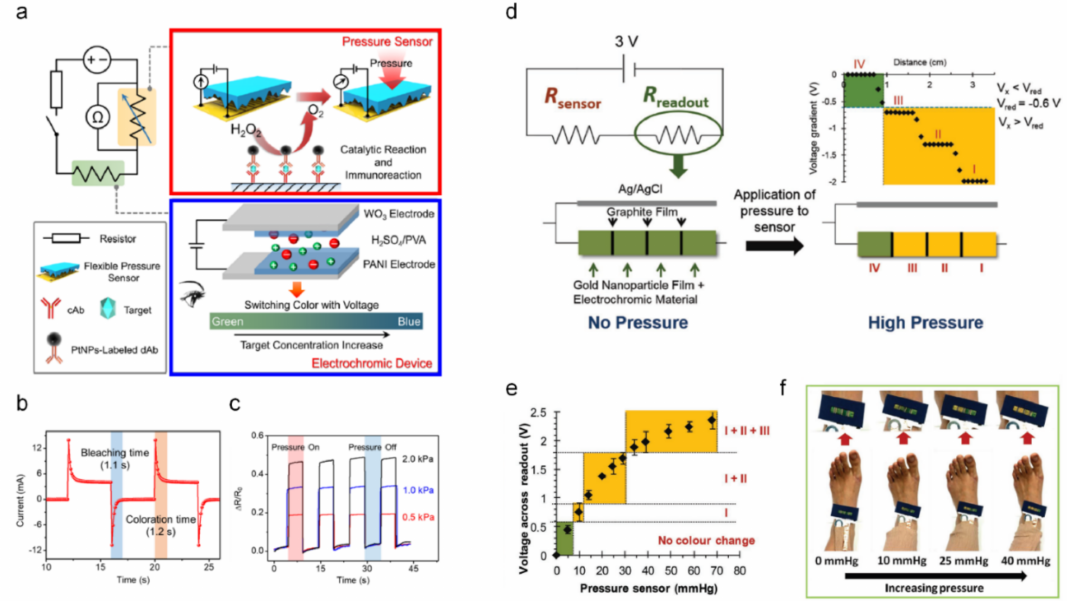
Figure 2. Pressure sensor integrated with EC visual detection (( a – c ) adapted with permission from ref. [24], copyright 2021 American Chemical Society and ( d – f ) adapted with permission from ref. [25] copyright 2016 Wiley-VCH Verlag GmbH & Co.). ( a ) Schematic circuit diagram of the pressure-based immunoassay platform; flexible pressure sensor by catalytic reaction and immunoreaction (red box) and voltage-regulated ECD as a visualized readout (blue box). ( b ) Color switching time of the ECD. ( c ) Pressure response of the designed skin-inspired pressure sensor. ( d ) Operating mechanism of the paper-based ECD is incorporated with a pressure sensor (Rsensor). The paper-based readout system consists of resistive graphite separators and gold nanoparticle segments (readout) with Prussian blue/polyaniline as electrochromic materials. ( e ) Visual readout of pressure vs. voltage by a gradual color change of the gold nanoparticle segments. ( f ) A pressure readout system was applied to the bandage at the